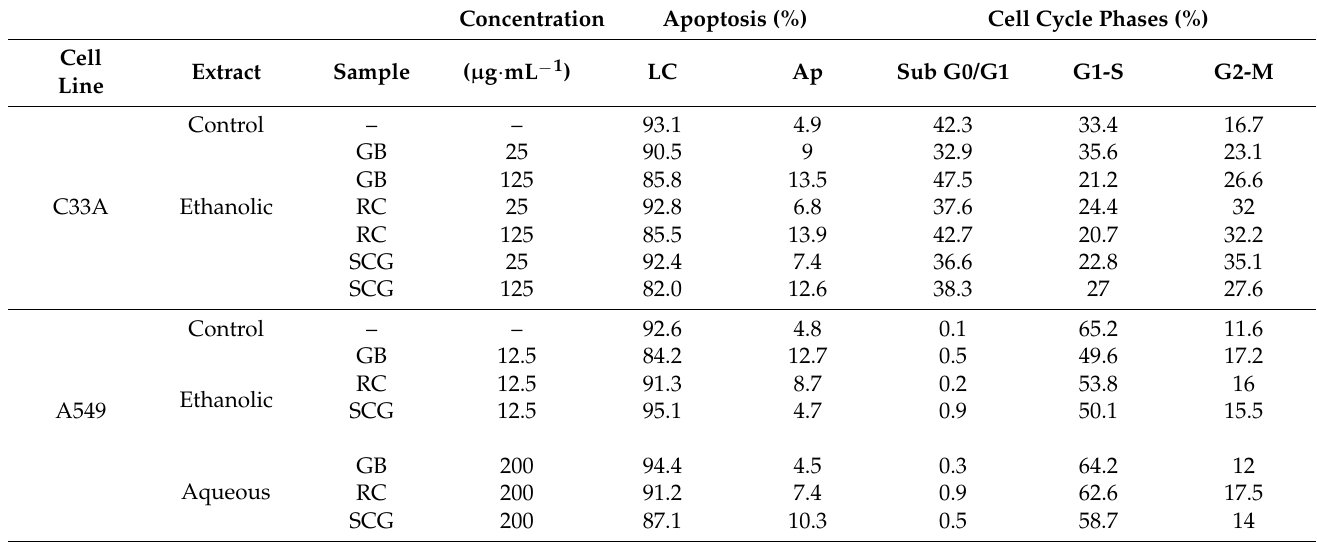
Table 3. Determination of apoptosis and cell-cycle phases in C33A and A549 cells treated with the different coffee